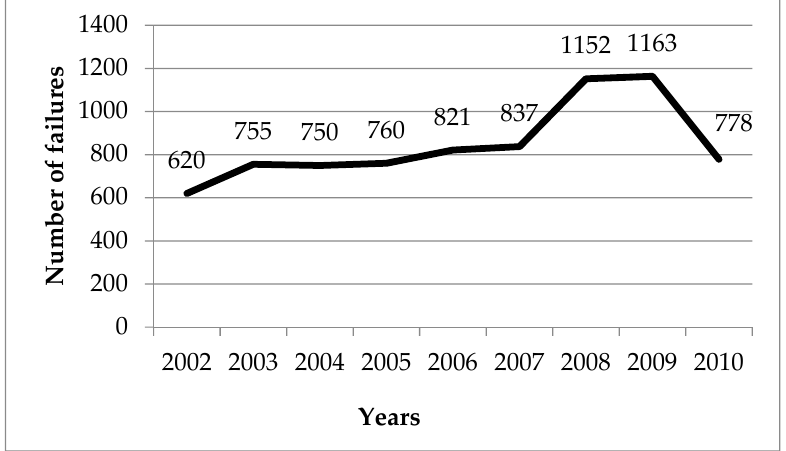
Figure 1. The annual evolution of the number of failures occurred in the water supply network of Cluj-Napoca during 2002 ‒ 2010 [14].